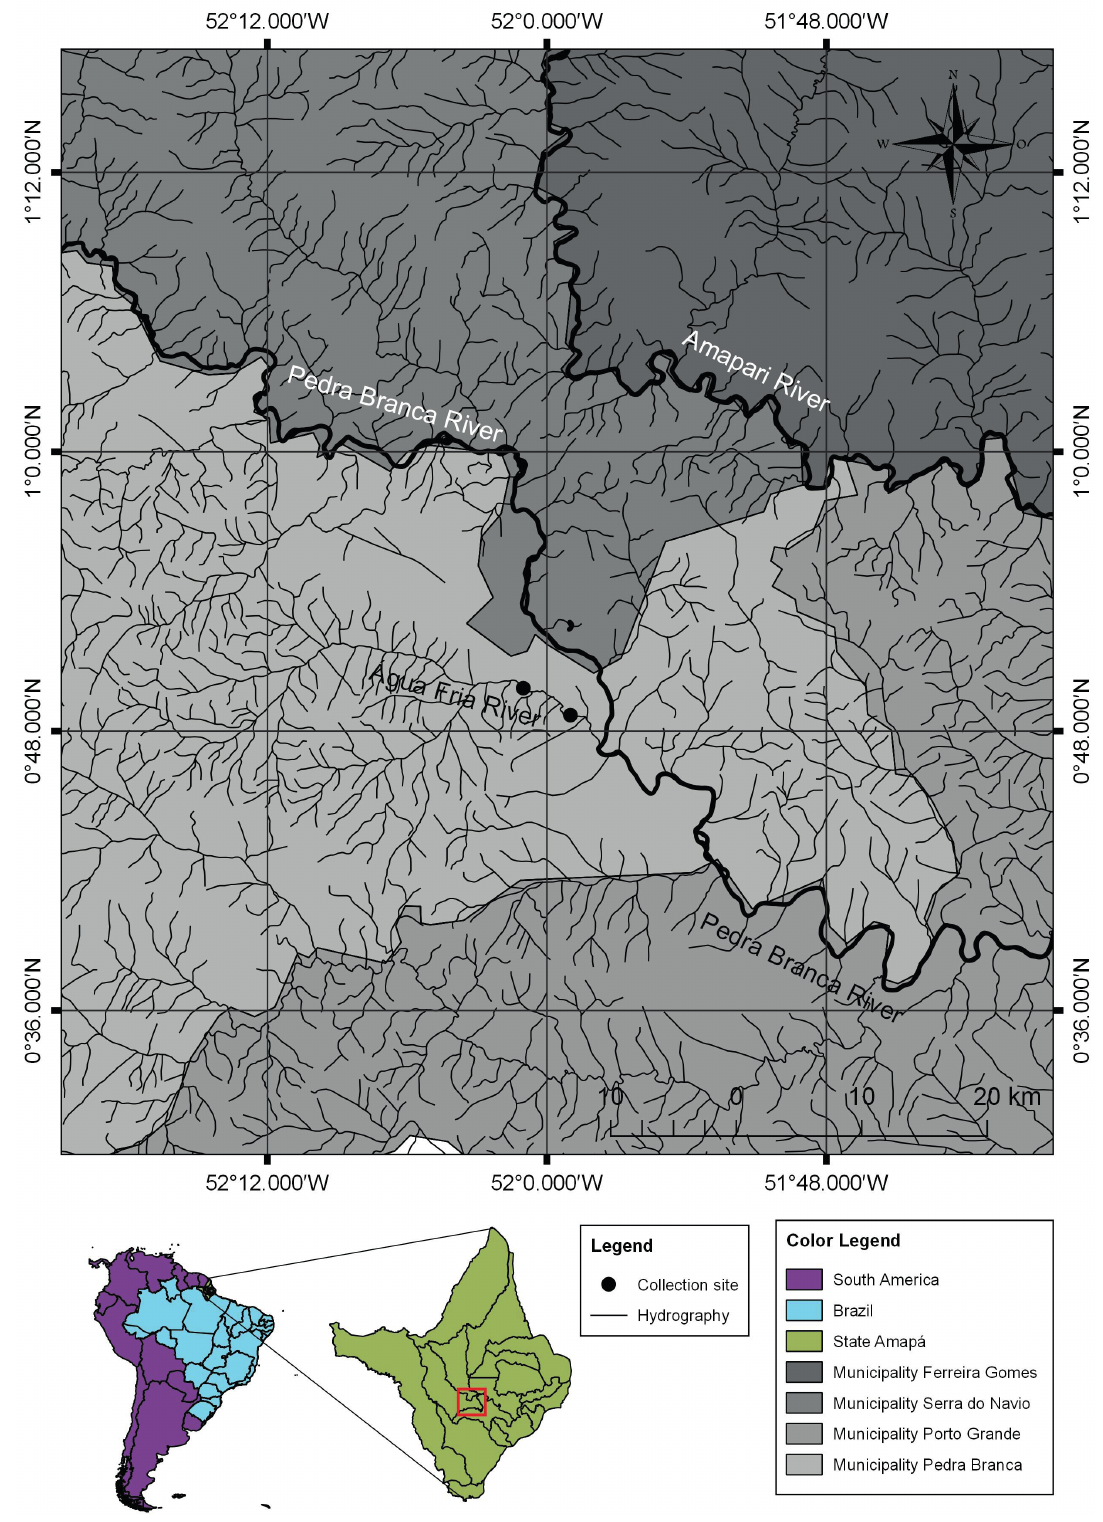
Figure 1 - Collection site of the four species of Corydoras endemic to the eastern Amazon